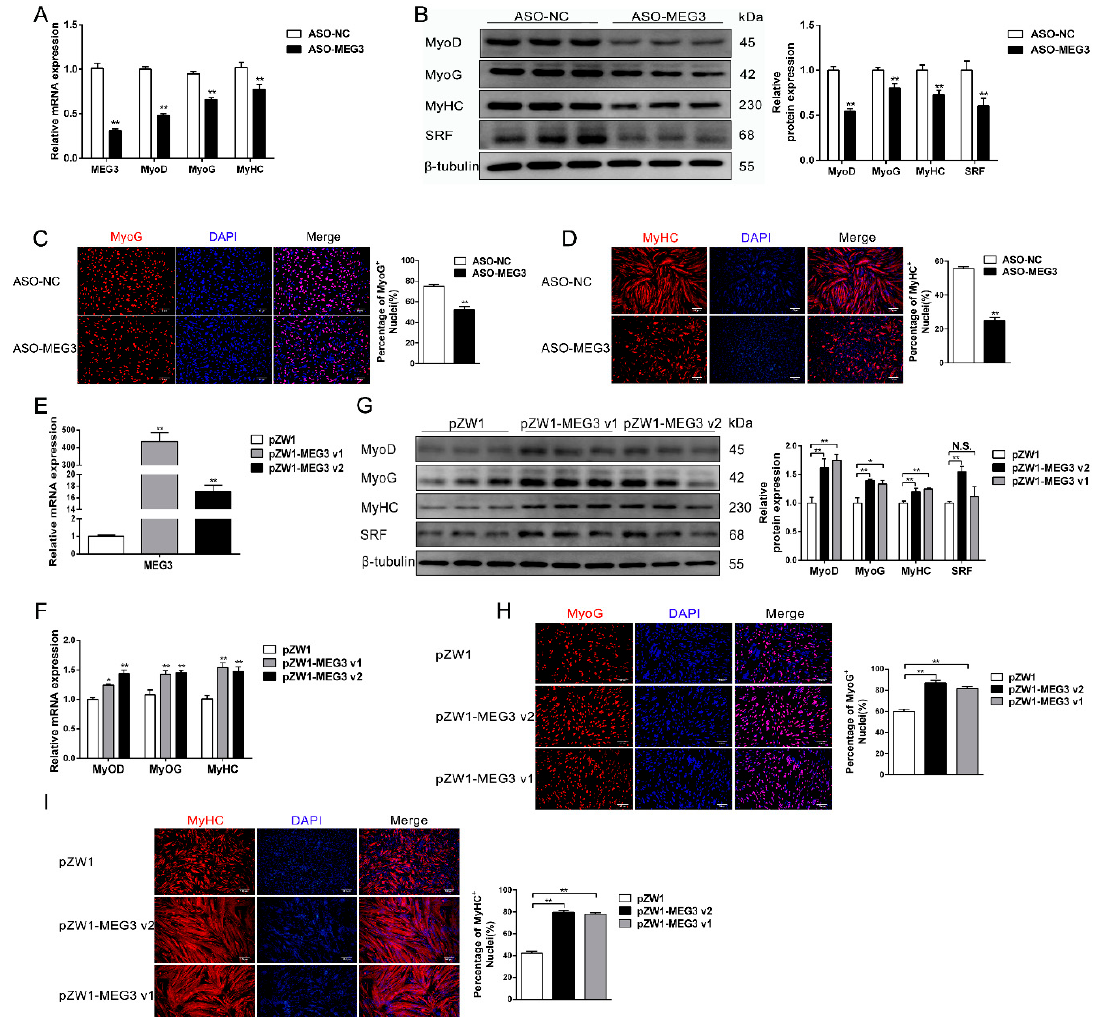
Figure 3. MEG3 promotes myogenic di ff erentiation of porcine satellite cells. ( A , B ) The real-time PCR ( A ) and Western blot analysis ( B ) showing that MEG3 knockdown significantly decreases expression levels of myogenic marker genes ( MyoD , MyoG , MyHC ) and SRF . ( C , D ) Immunofluorescence staining of MyoG ( C ) and MyHC ( D ) in porcine satellite cells after transfection with ASO– MEG3 or ASO–NC showing that MEG3 knockdown significantly reduces the positively stained cells of MyoG and MyHC . ( E ) The detection of overexpression e ffi ciency of MEG3 v1 and MEG3 v2. ( F – I ) qPCR ( F ), Western blot ( G ), and immunofluorescence staining of MyoG ( H ) and MyHC ( I ) results showing that MEG3 overexpression promotes satellite cell di ff erentiation. Scale bar of ( C , H ): 50 µ m. Scale bar of ( D , I ): 100 µ m. Porcine satellite cells were harvested after transfection with MEG3 ASO or overexpression plasmid and di ff erentiation for 48 h. The relative mRNA levels were normalized to those of the control 18S rRNA . The relative protein levels were normalized to those of the control β -tubulin . Error bars represent mean ± SEM of three biological replicates. Statistical significance of di ff erences was assessed by Student’s t -test. * p < 0.05, ** p < 0.01. N.S. means that there was no significant di ff erence. NC, negative control. qPCR, quantitative polymerase chain